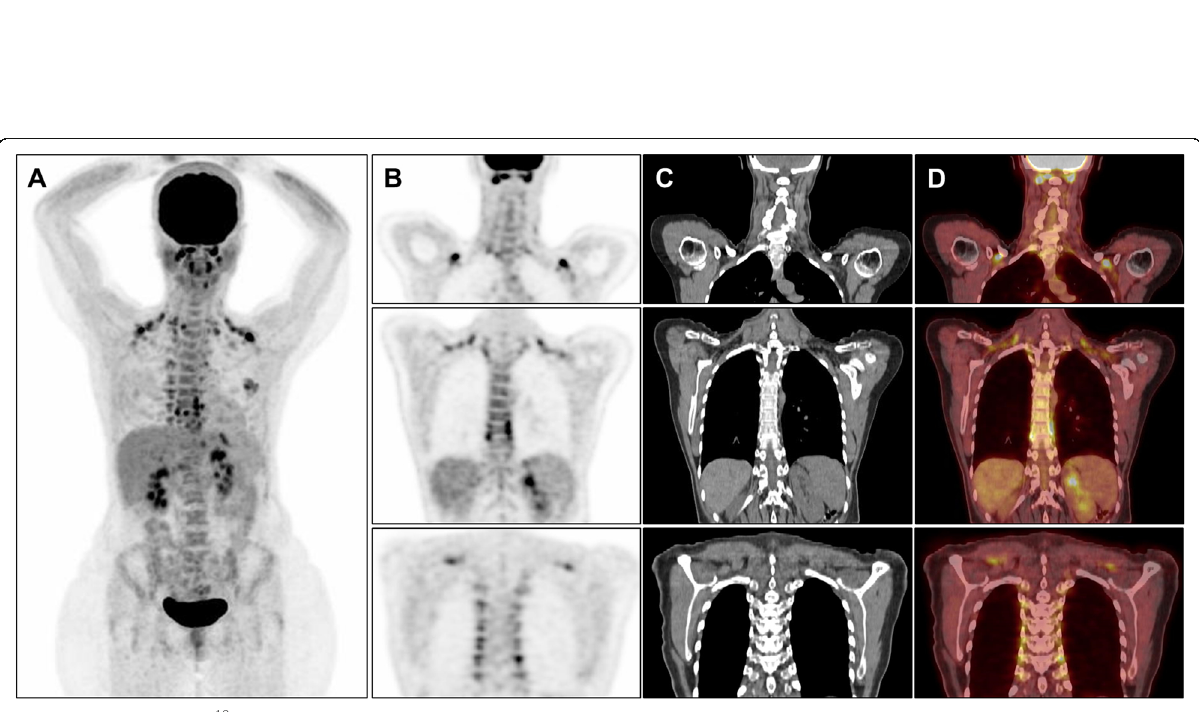
Fig. 2 Brown fat uptake: 18 F-FDG PET/CT scan of a 46-year-old female with luminal B invasive lobular carcinoma of the left breast: a maximum intensity projection and b coronal PET show intense 18 F-FDG uptake in the cervical, supraclavicular, and paravertebral regions. c The corresponding CT and d coronal PET/CT fusion images reveal that 18 F-FDG uptake is corresponding to fatty tissue and there is no abnormal lymph node or muscle uptake, denoting activated